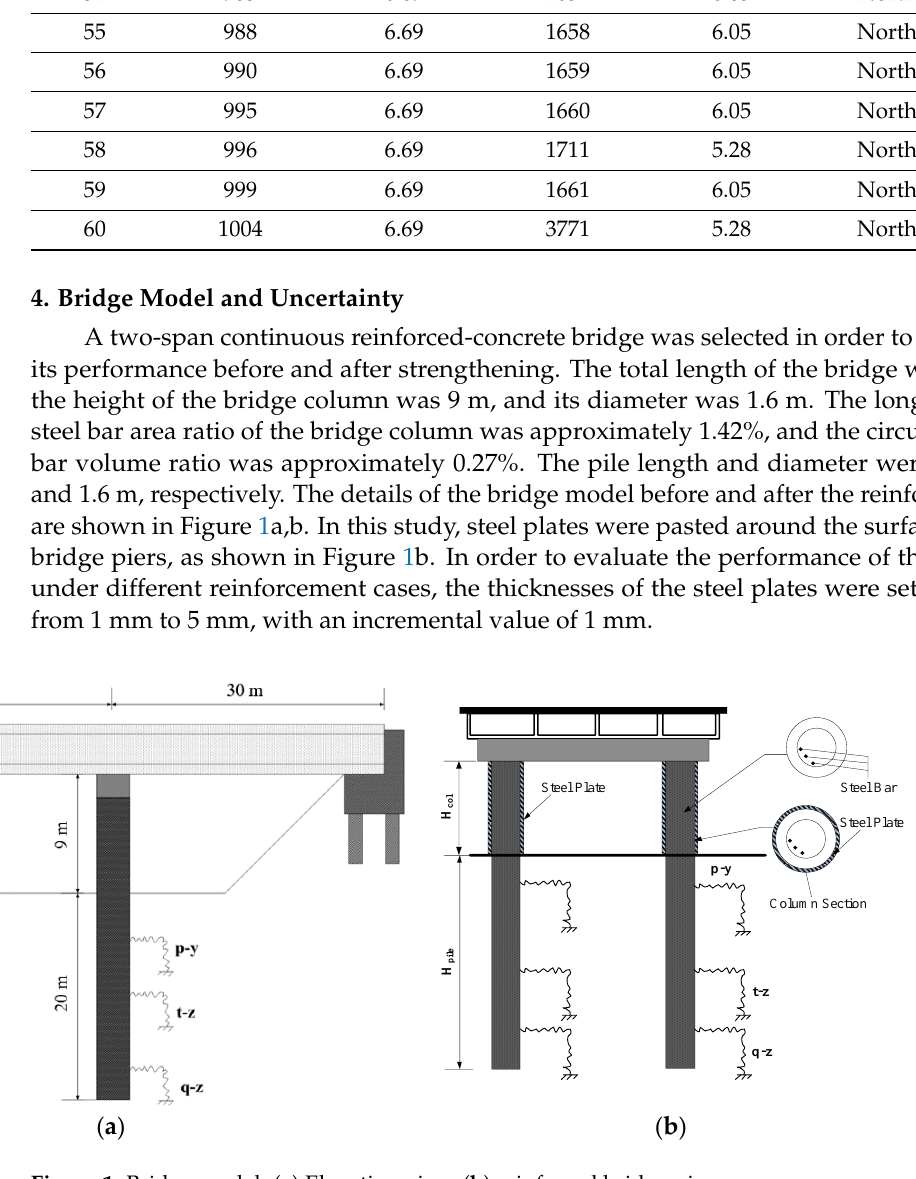
Figure 1. Bridge model. ( a ) Elevation view, ( b ) reinforced bridge piers.